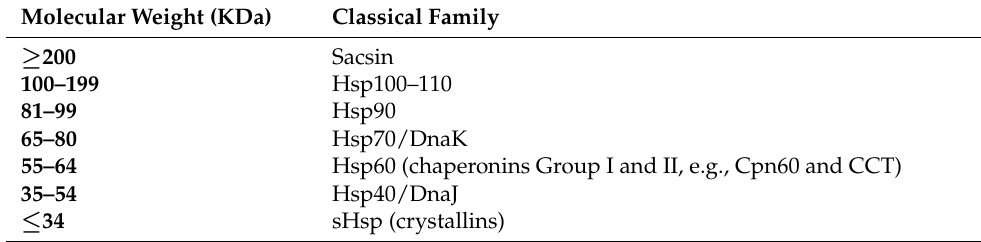
Table 1. Major molecular